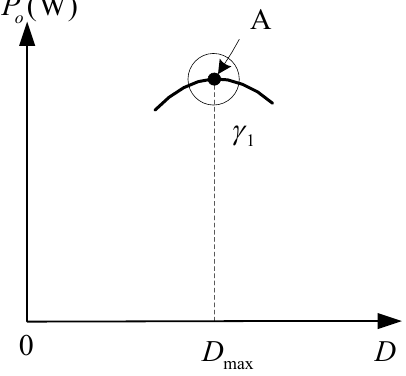
Figure 7. Regularity under (1) or (3) conditions.